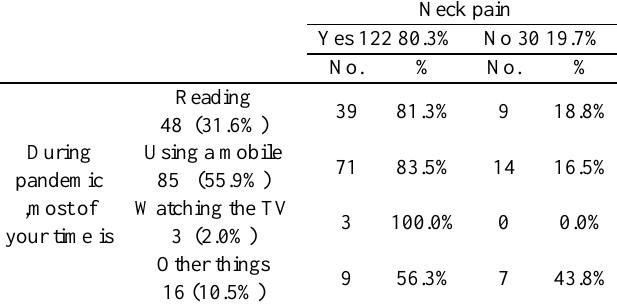
The correlation between the daily average of using smart phone and neck pain summarized in (table 5). The students who using